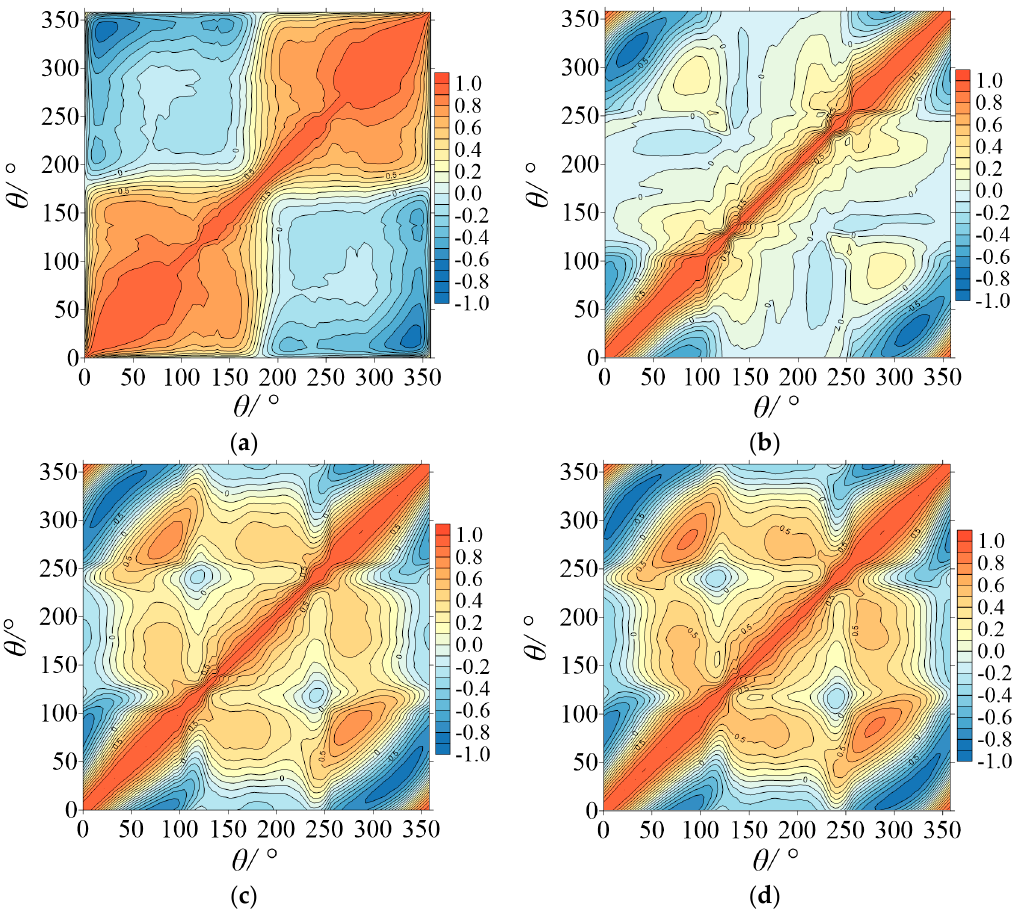
Figure 23. Correlation coe ffi cients of wind pressure in turbulent flow. ( a ) I u = 0%; ( b ) I u = 4%; ( c ) I u = 8%; ( d ) I u = 12%.